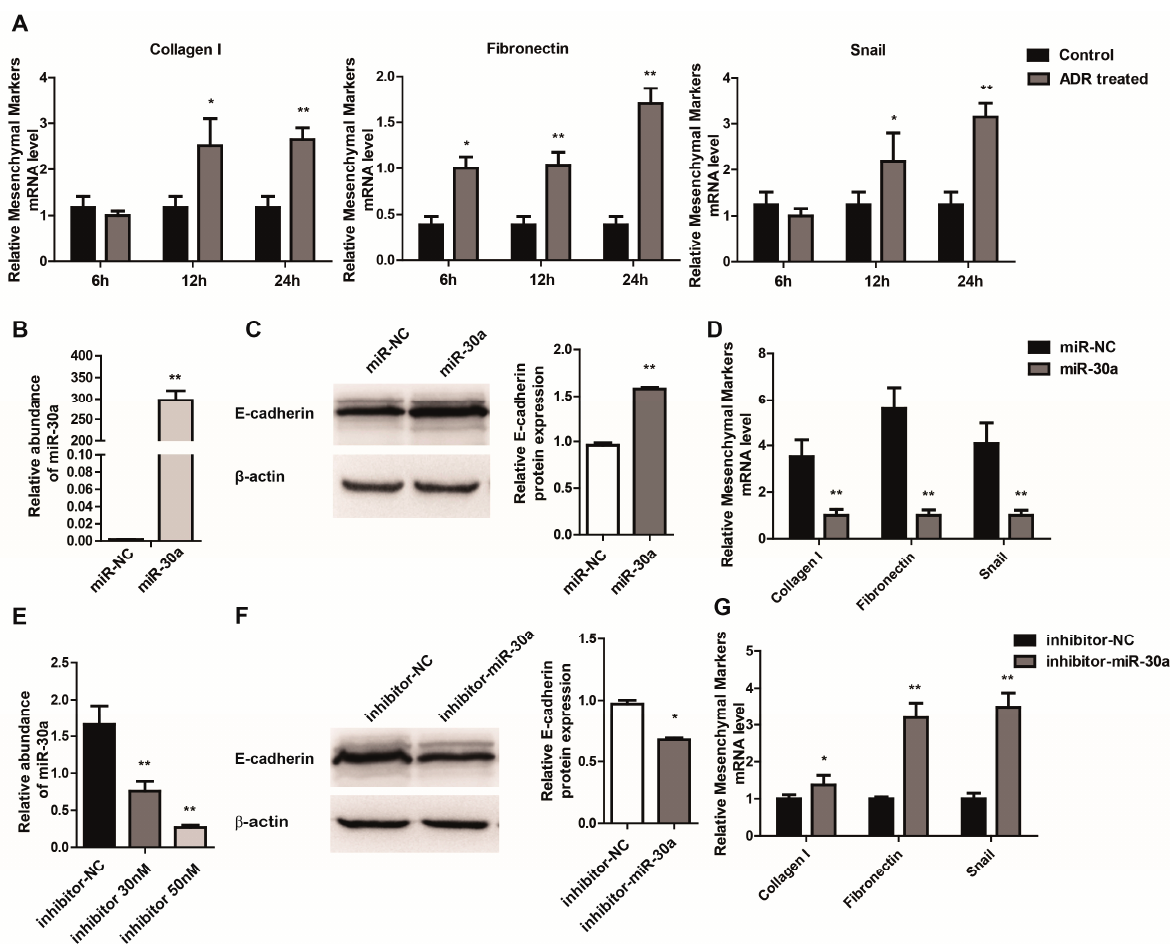
Figure 2. MiR-30a Inhibits Epithelial-to-Mesenchymal Transition in Podocytes. ( A ) RT-qPCR analysis of mesenchymal markers (Collagen I, Fibronectin and Snail) expression levels in cultured MPC5 cells treated with ADR (5.0 µg/mL) at different time points (6, 12 and 24 h); ( B ) RT-qPCR analysis of miR-30a expression levels in cultured MPC5 cells transfected with miR-30a (30 nM) or miR-NC; ( C ) Western blot analysis of epithelial markers (E-cadherin) expression levels in cultured MPC5 cells transfected with miR-30a (30 nM) or miR-NC. Quantitative analysis of E-cadherin protein levels after normalization with β -actin; ( D ) RT-qPCR analysis of mesenchymal markers (Collagen I, Fibronectin and Snail) expression levels in cultured MPC5 cells transfected with miR-30a (30 nM) or miR-NC; ( E ) RT-qPCR analysis of miR-30a expression levels in cultured MPC5 cells transfected with inhibitor-30a (30 or 50 nM) or inhibitor-NC; ( F ) Western blot analysis of epithelial markers (E-cadherin) expression levels in cultured MPC5 cells transfected with inhibitor-30a (50 nM) or inhibitor-NC. Quantitative analysis of E-cadherin protein levels after normalization with β -actin; ( G ) RT-qPCR analysis of mesenchymal markers (Collagen I, Fibronectin and Snail) expression levels in cultured MPC5 cells transfected with inhibitor-30a (50 nM) or inhibitor-NC. The relative amount of miR-30a and mRNA was normalized to that of control RNA (U6) and 18s, respectively. All data are presented as means ± SD from three independent experiments. * p < 0.05, ** p < 0.01, indicate statistically significant and highly statistically significant differences,